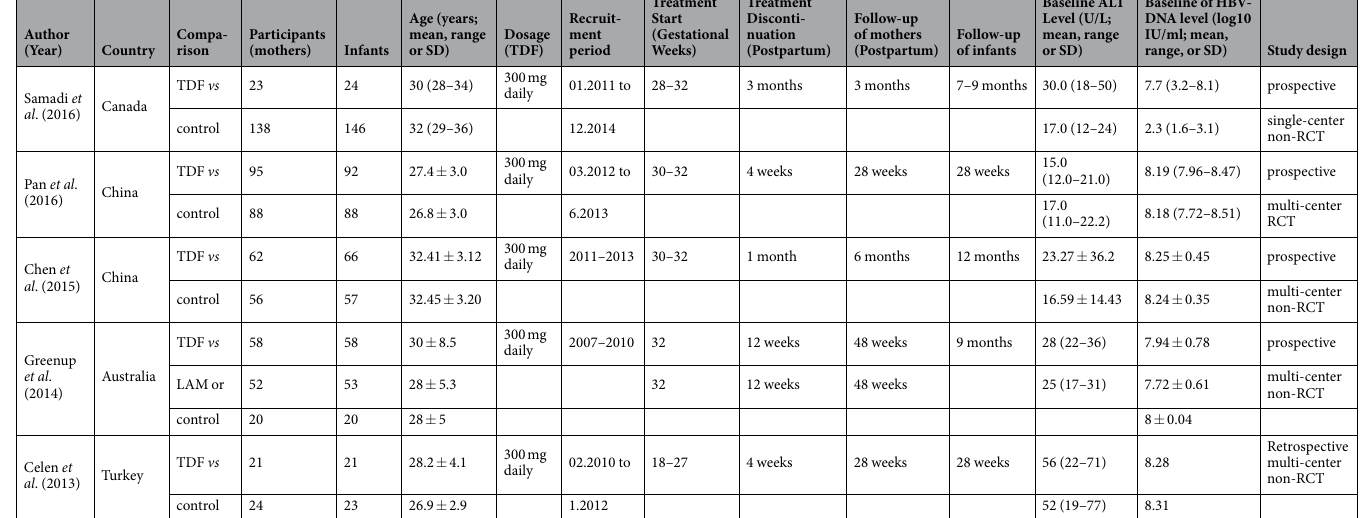
Table 1. Characteristics of the 5 included studies. Abbreviations: TDF, tenofovir disoproxil fumarate; LAM, lamivudine; ALT, alanine aminotransferase; HBIG, hepatitis B immune globulin; NA, not available.